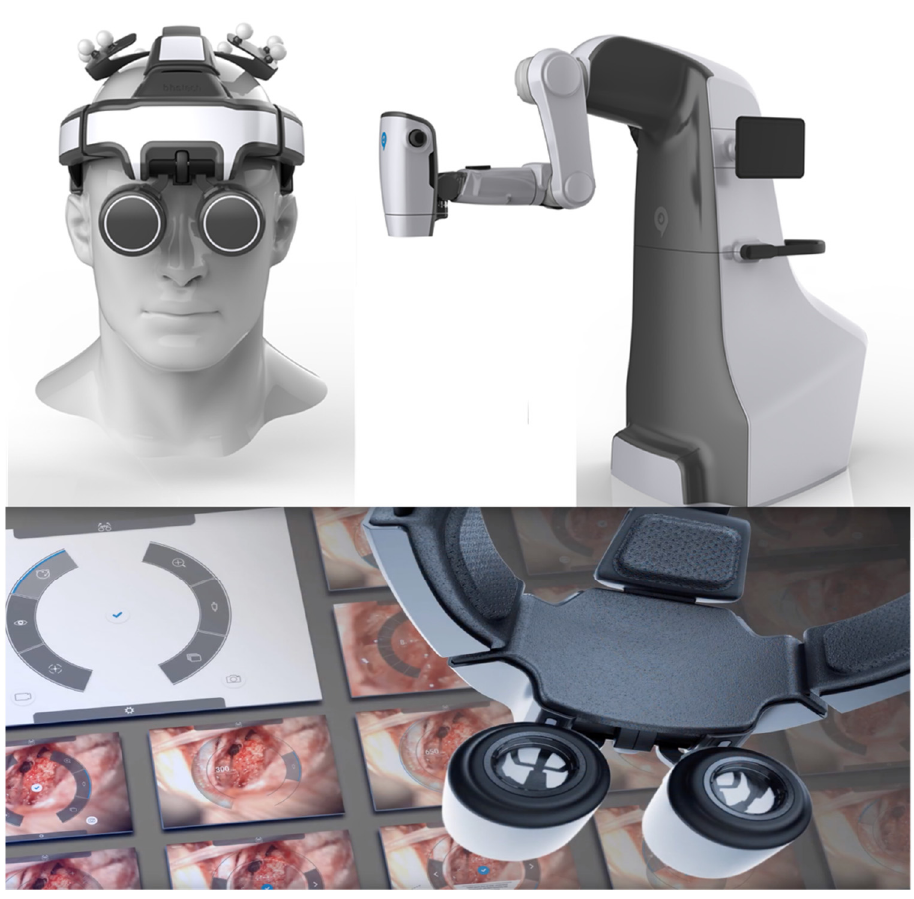
Figure 4. Robotic microscope system RoboticScope from BHS Technologies (printed with the permis- sion of BHS